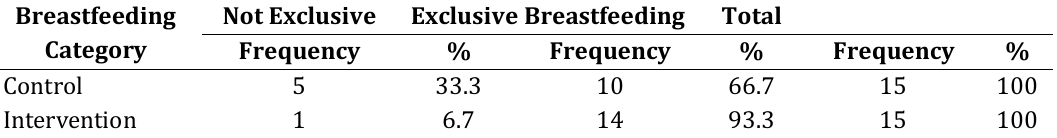
Breastfeeding Category